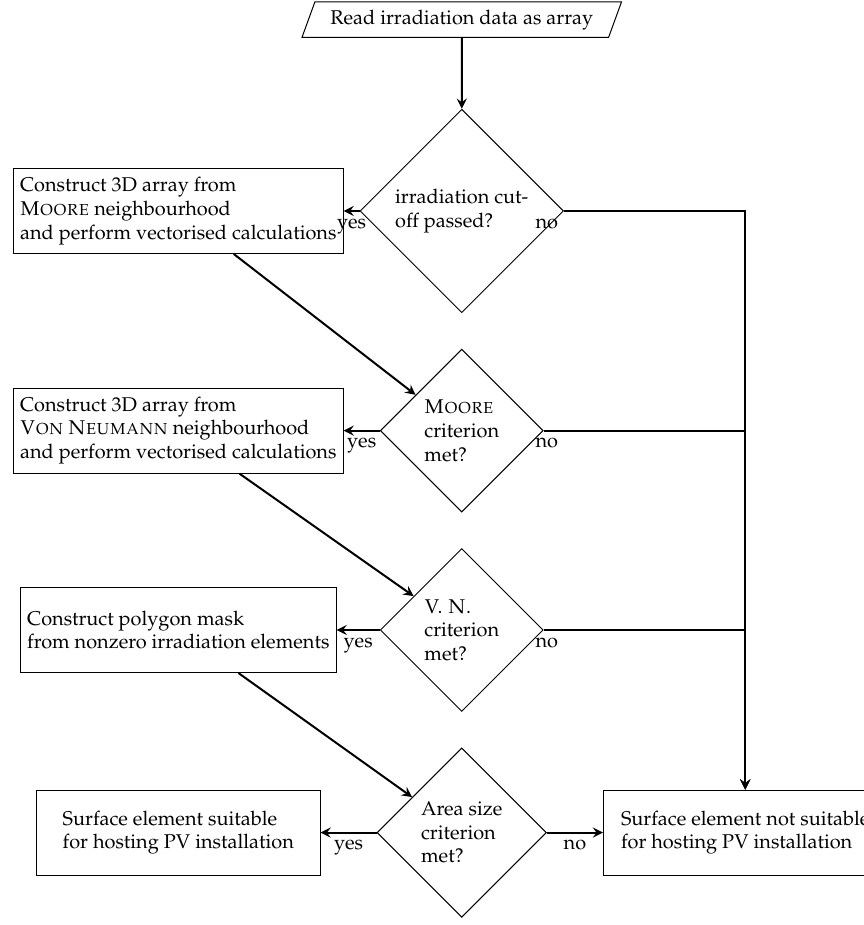
Figure 3. Flowchart illustrating the presented